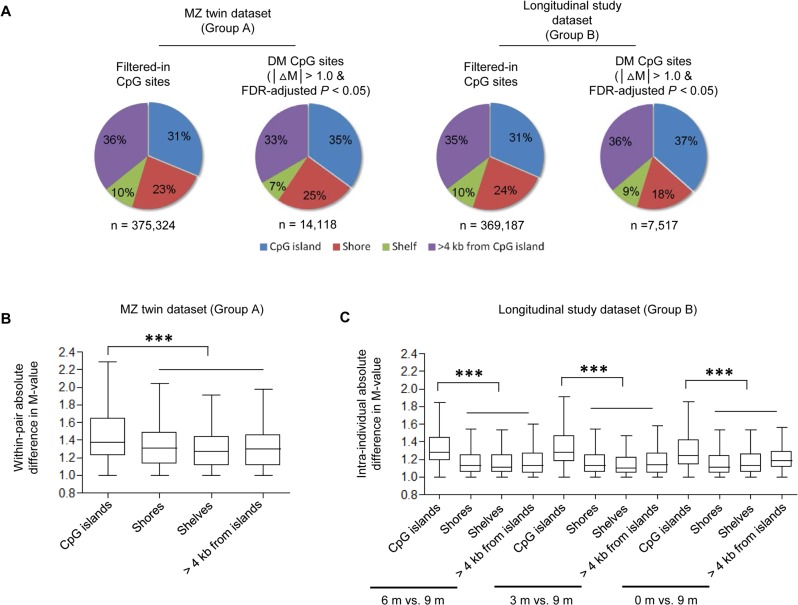
Relationship between position of CpG sites and differences in DNA methylation.(A) Comparison of the genomic distribution of DM CpG sites detected within at least one MZ twin pair (Group A, upper panel) or within a subject 3, 6, or 9 months apart (Group B, lower panel) under |ΔM| > 1 and FDR-adjusted P value < 0.05. n, the number of CpG sites satisfying the thresholds. (B-C) |ΔM| values within MZ twin pairs (B) or within the same individuals (C) plotted against their annotated locations. Black lines within each box represent the median of |ΔM|. The statistical analysis was performed using a non-parametric equivalent of one-way analysis of variance (ANOVA), the Kruskal-Wallis test, followed by a Bonferroni's/Dunn's multiple comparison test, ***P < 0.001.